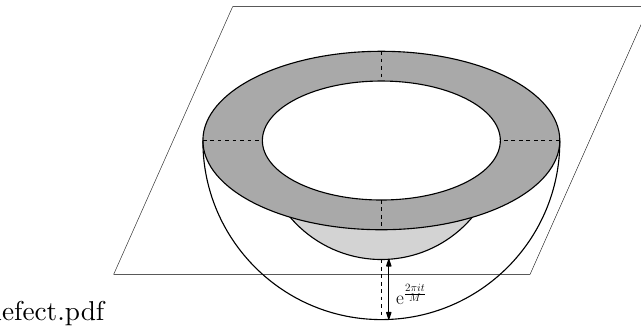
Figure 2 . Conical defect obtained from the Schottky parametrization. We chose M = 4 in the figure. This is the same as for thermal AdS 3 , except for the additional identification that reduces the fundamental domain to a slice of the